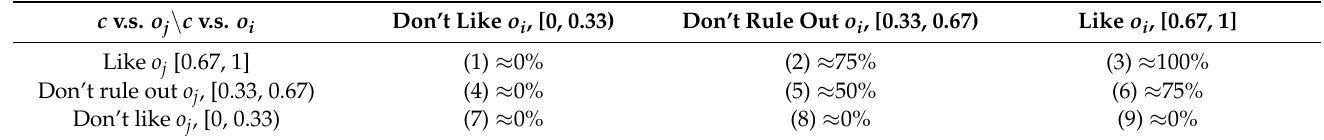
Table 2. Customer preferences in relation to o i and o